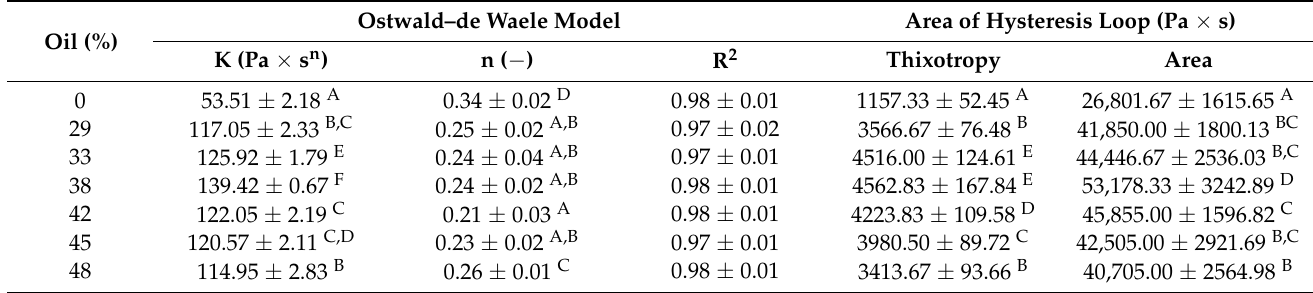
Table 2. Parameters of the Ostwald–de Waele rheological model and area of the hysteresis loop of the hydrogel with encapsulated safflower